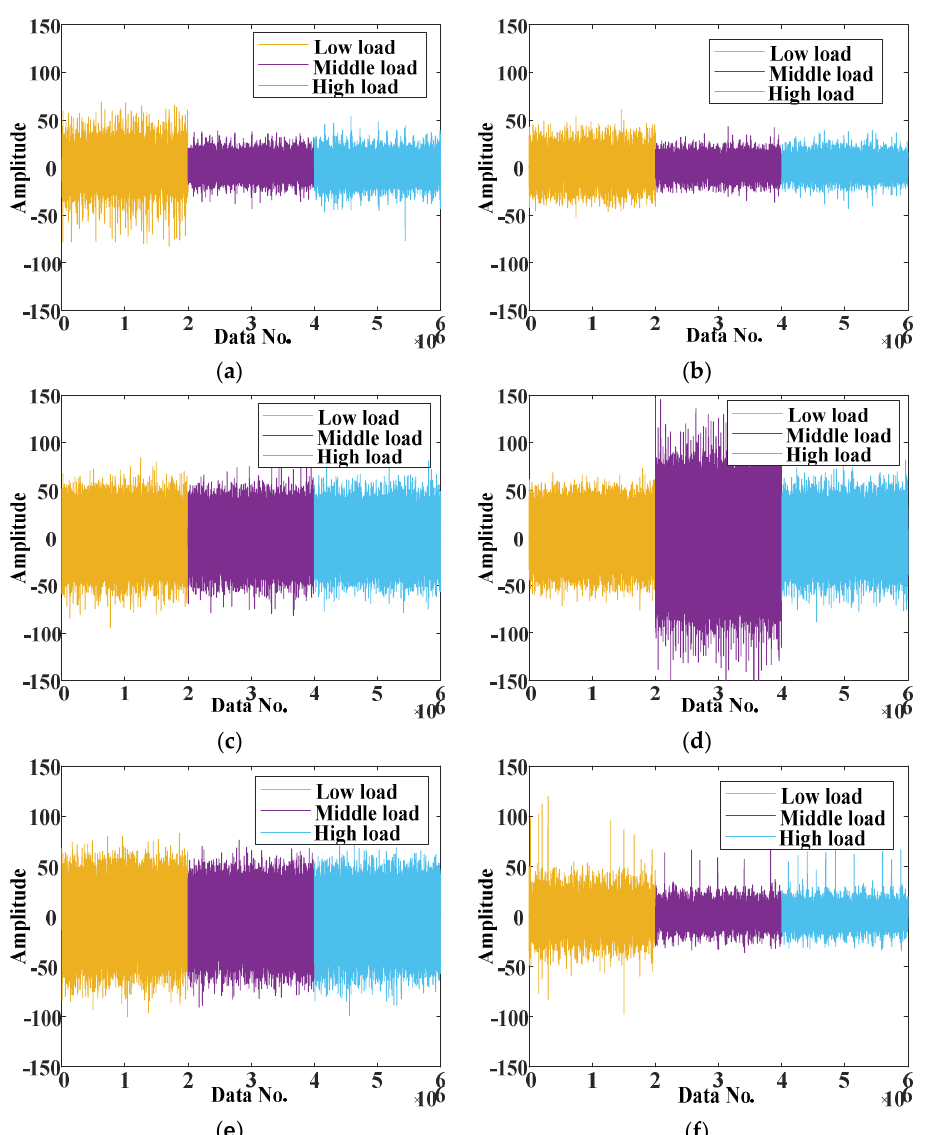
Figure 4. The raw signals: ( a ) C0 condition; ( b ) C1 condition; ( c ) C2 condition; ( d ) C3 condition; ( e ) C4 condition; ( f ) C5 condition.